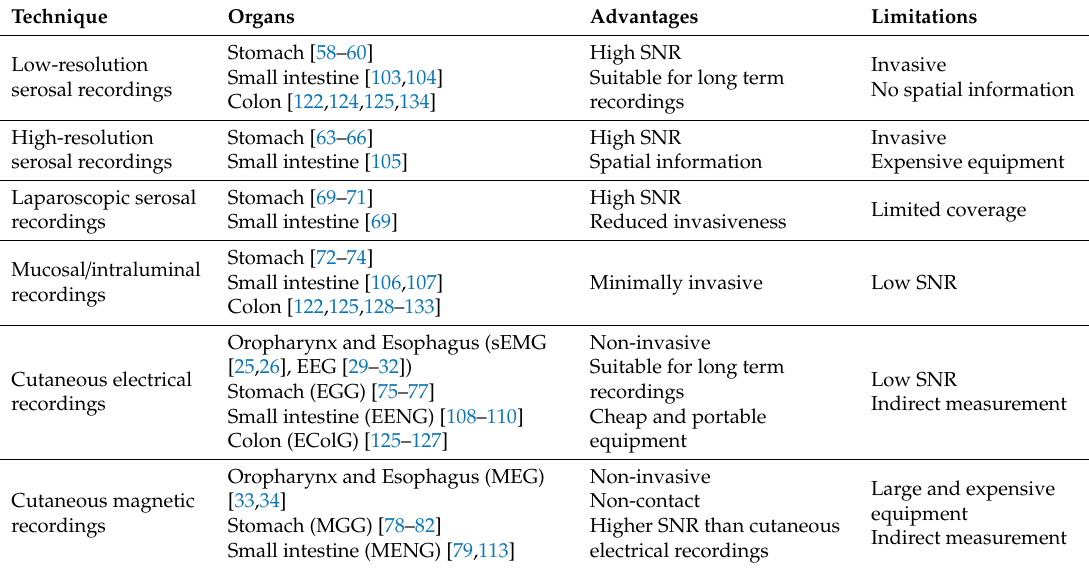
Table 1. The techniques to measure the bioelectrical activity along the GI